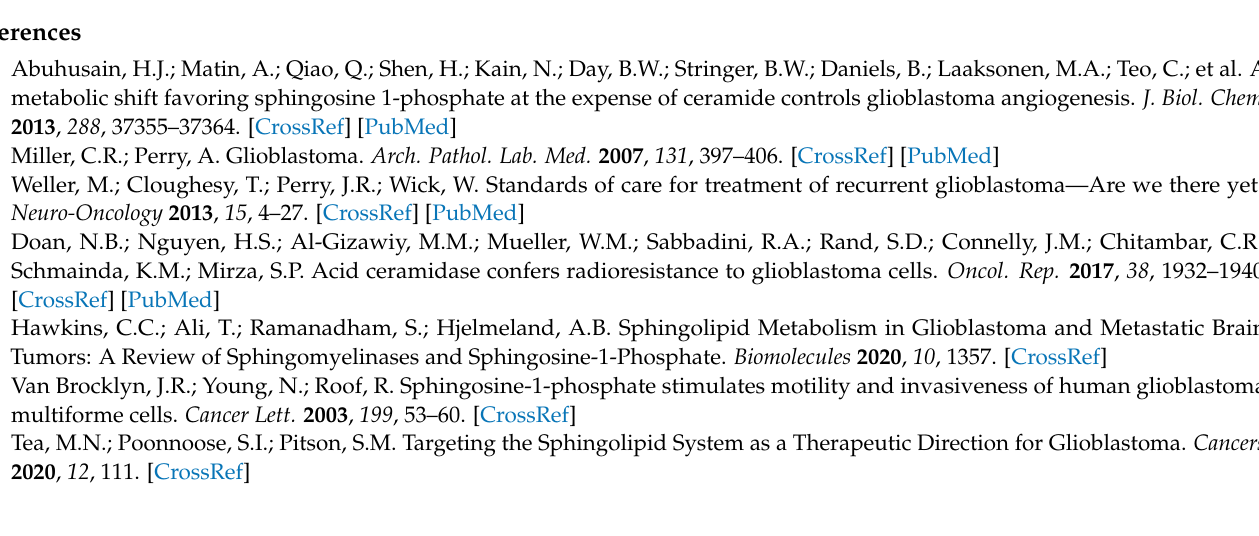
grade gliomas, Figure S2: GSEA tables for ASAH1 correlations, Figure S3: Growth analysis with ASAH1 shRNA #2, Figure S4: Growth analysis with ASAH1 inhibitors, Figure S5: Migration analysis with B13, Figure S6: ASAH1 expression with FBS media, Figure S7: Invasion and phospho-FAK analysis, Figure S8: Diseases and disorders from IPA, Figure S9: Molecular and cellular functions from IPA, Figure S10: AKT expression with B13, Figure S11: Full-sized blots for Figure 8, Figure S12: Full-sized blots for supplemental figures. Replicates for each experiment are available upon